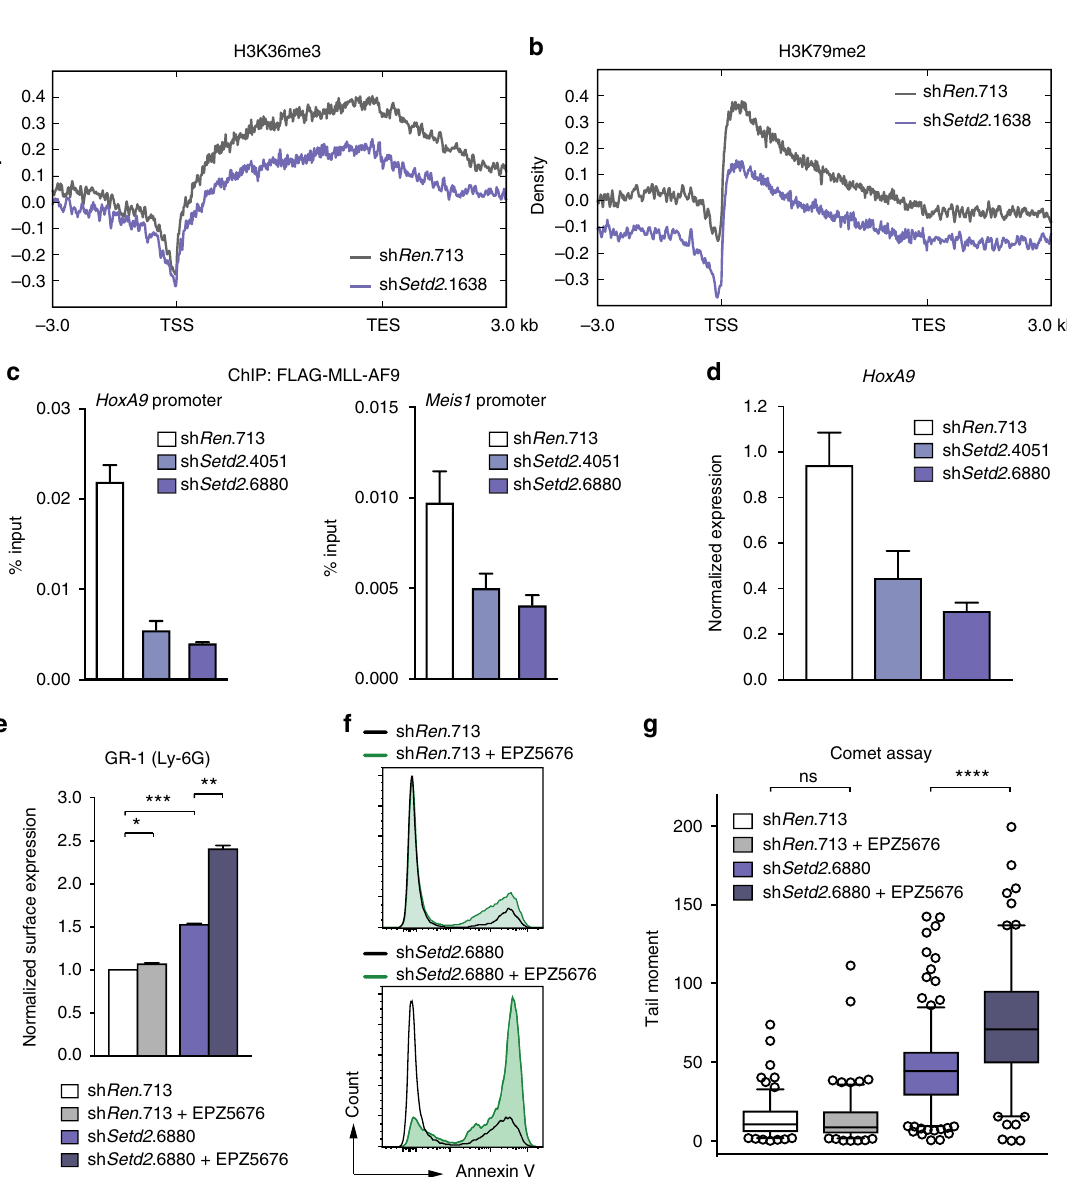
Fig. 8 SETD2 loss sensitizes AML cells to DOT1L inhibition. Metagene plots of ChIP-Rx data for H3K36me3 ( a ) and H3K79me2 ( b ) after shRNA-mediated knockdown of Setd2 in mouse MLL-AF9/Nras G12D AML cells. c qPCR analysis of enrichment on HoxA9 and Meis1 promoter regions after MLL-AF9-FLAG- ChIP upon shRNA-mediated knockdown of Setd2 (mean ± s.d. n = 3). d qPCR analysis of HoxA9 mRNA levels in MLL-AF9-FLAG cells expressing indicated shRNAs (mean ± s.d. n = 3). e Quanti fi cation of surface expression of Gr-1 (Ly-6G) after shRNA-mediated knockdown of Setd2 in mouse MLL-AF9/ Nras G12D AML cells treated with EPZ5676 (500 nM) (mean± s.d. n = 2). f Flow cytometric analysis of Annexin V-positive cells in MV4-11 cells treated with EPZ5676 (50 nM) after shRNA-mediated knockdown of SETD2 . g Quanti fi cation of tail moments in an alkaline comet assay performed after shRNA- mediated knockdown of Setd2 in mouse MLL-AF9/Nras G12D AML cells treated with EPZ5676 (500 nM). Quanti fi cation of >150 cells is shown. ns, not signi fi cant, * p < 0.05, ** p < 0.01, *** p < 0.001, **** p > 0.0001 ( t